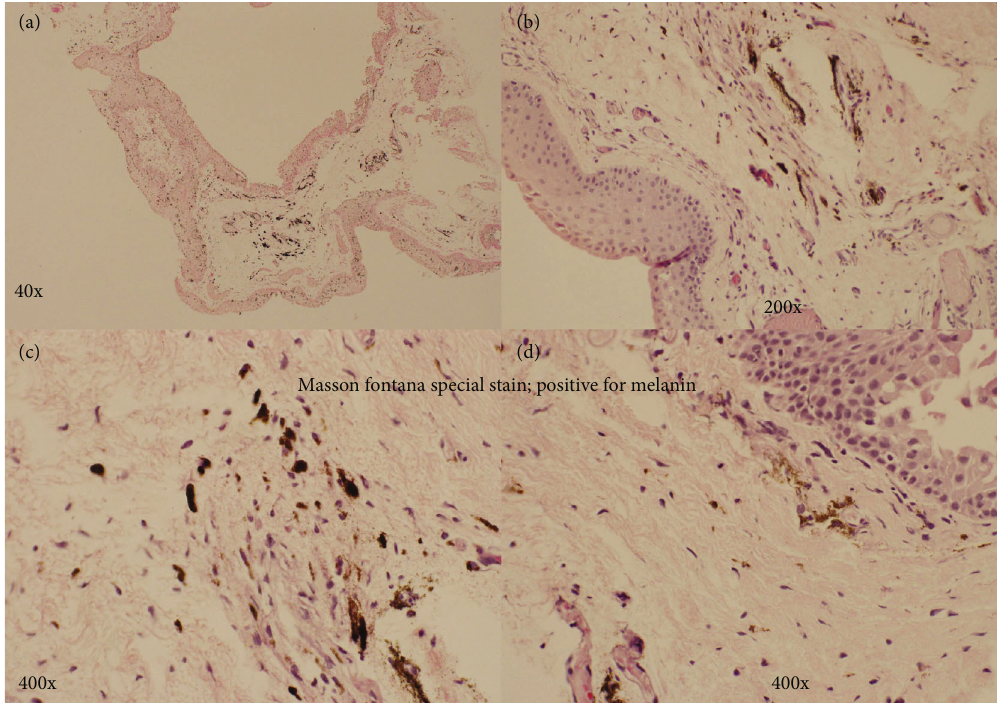
Figure 5: The Masson-Fontana special stain showing positive for melanin